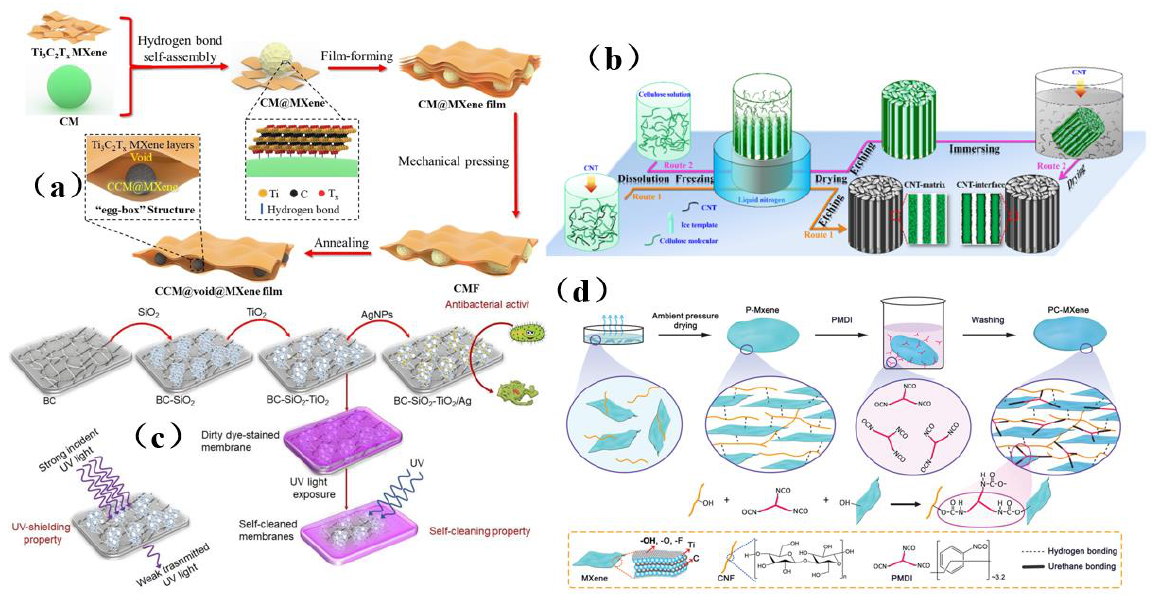
Figure 23. ( a ) Schematic diagram showing the fabrication of CCM@void@MXene composite